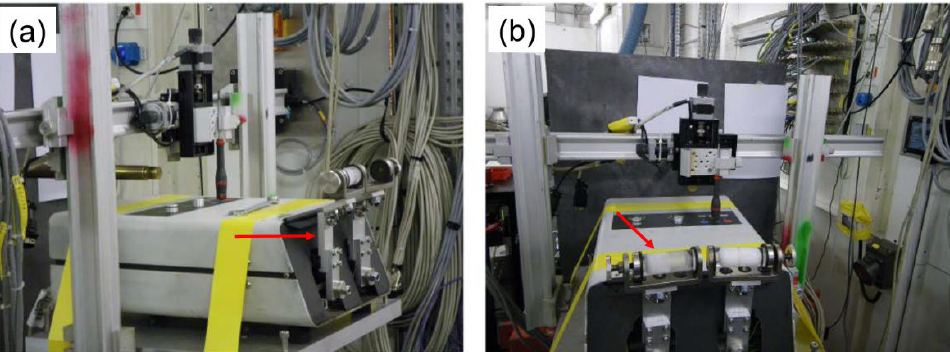
Figure 1. ( a ) Positioning of a modified Retsch MM200 mill on a motorized, movable x-,y-,z-stage at the ESRF beamline ID15B with modified arms (red arrow). ( b ) Modified arms position the polymer vessels (red arrow) in the X-ray beam. Reprinted with permission from [48]. Copyright 2013, John Wiley and Sons.